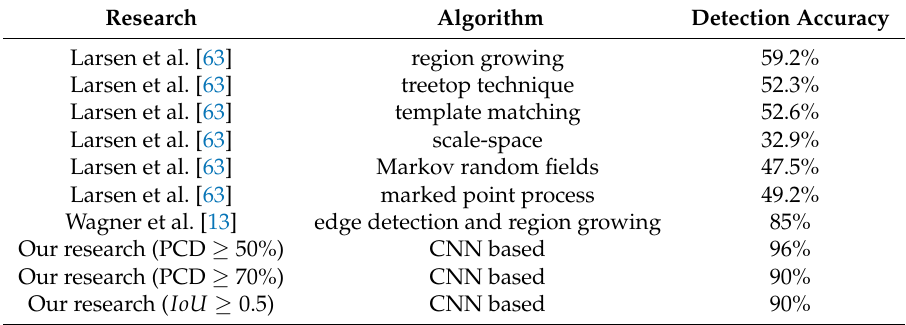
Table 8. Comparison between the detection accuracy in the research developed by [63] (region with high crown density), Wagner et al. [13] and our research considering three situations: for tree crowns with pixels correctly detected (PCD) ≥ 50%; crowns with PCD ≥ 70%; and for tree crowns with IoU ≥